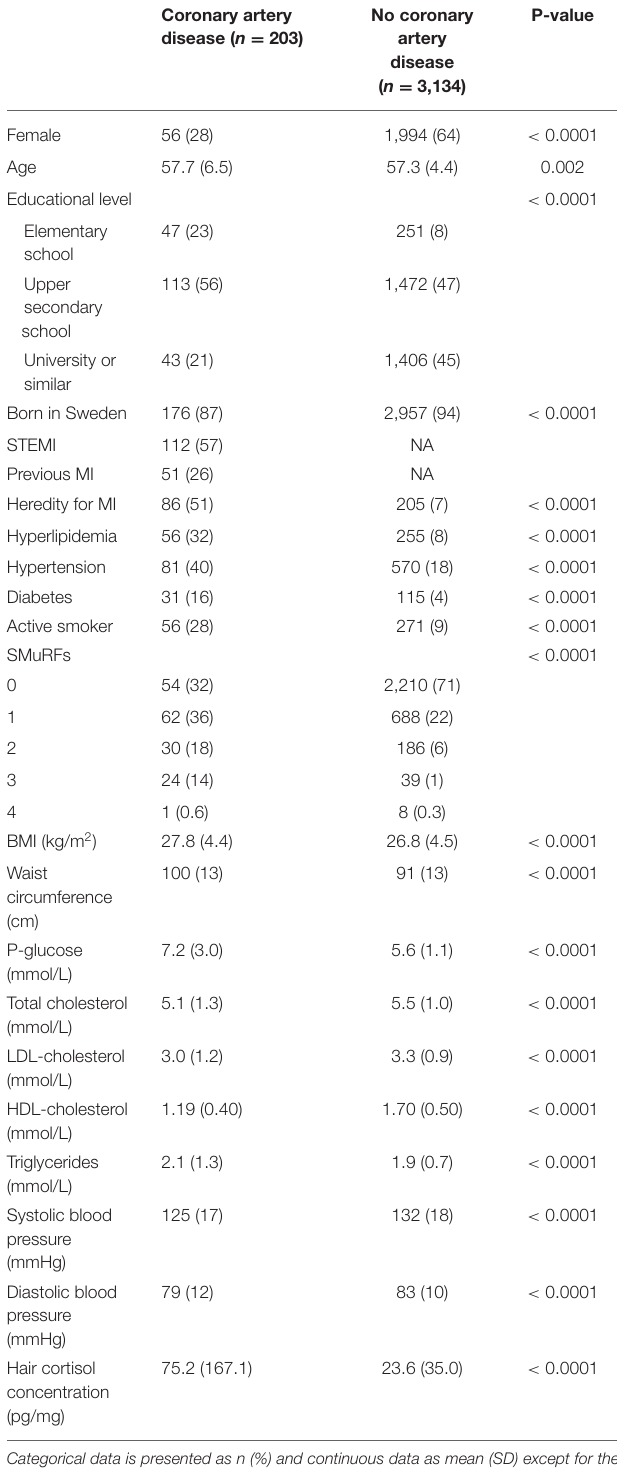
TABLE 1 | Characteristics of included participants grouped according to coronary artery disease (CAD)